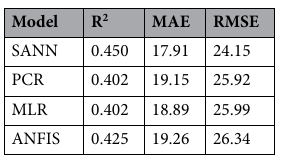
Table 3. Performance comparison of the